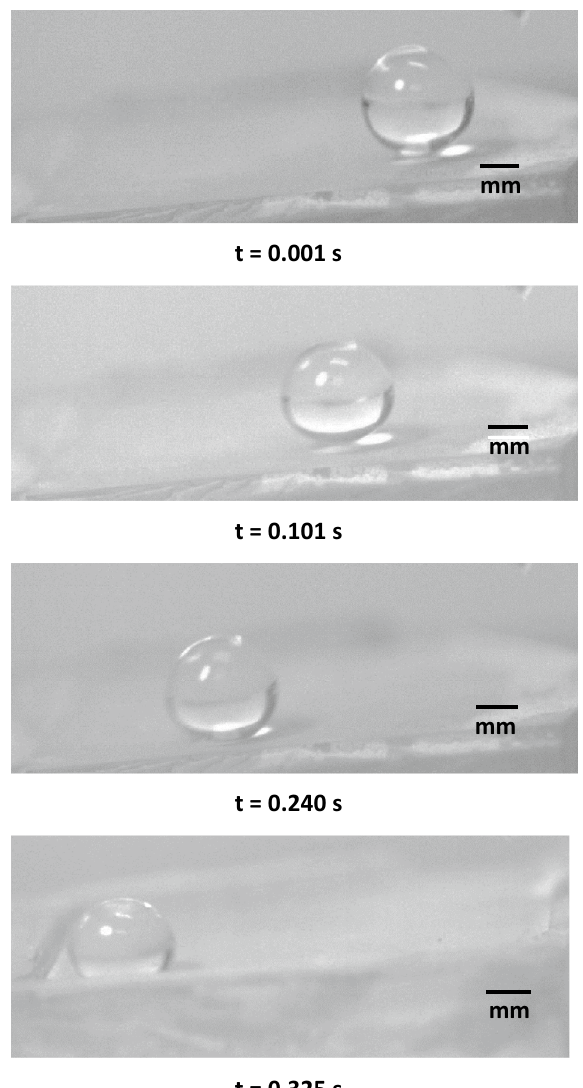
Figure 3. High-speed camera images of a water droplet on micro-post array surface at different durations. Droplet size is 40 μL, inclination angle δ = 5°, and micro-post spacing is 25